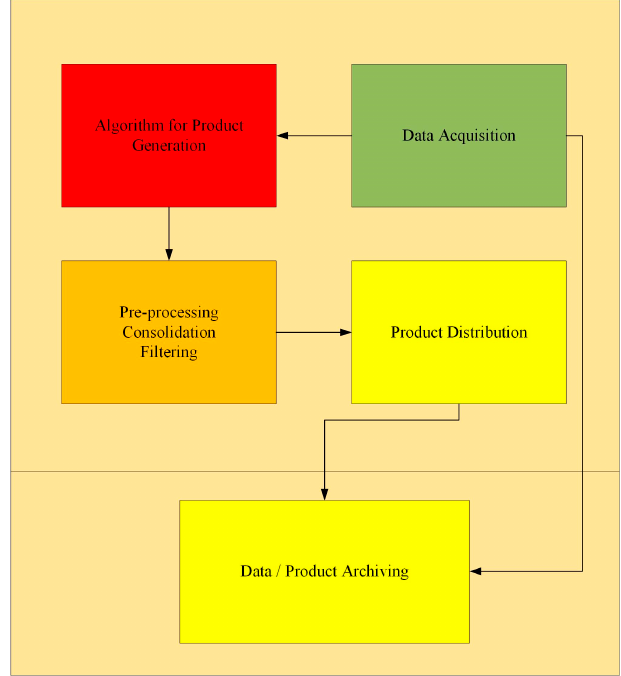
Figure 3. Microservice components .